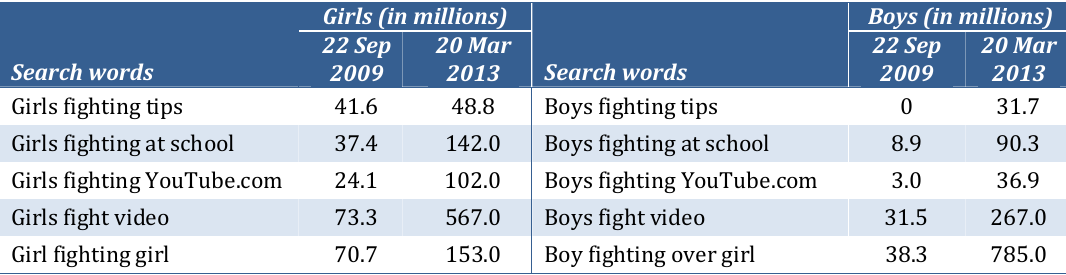
Table 1: Google search results: Fight sites by sex